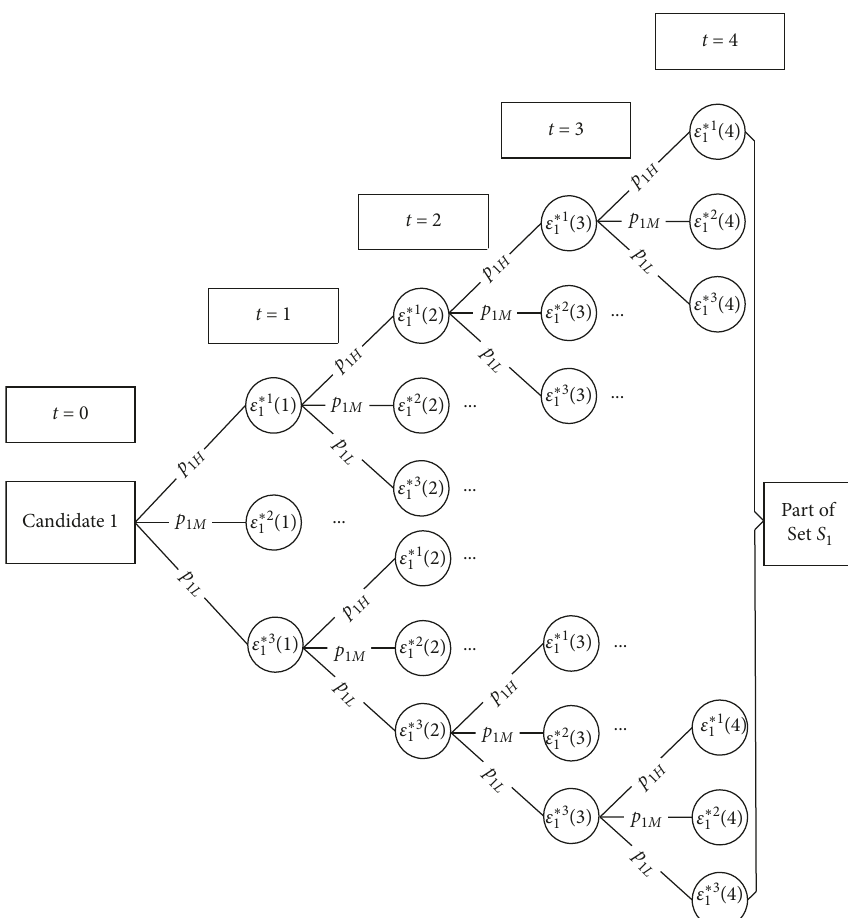
Figure 5: Scenario tree (random inflows of candidate